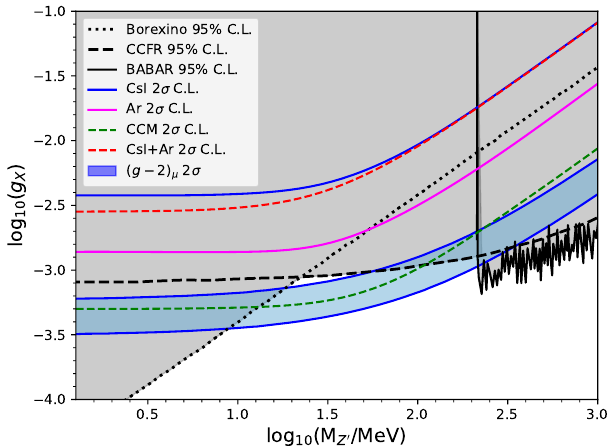
Figure 2. The parameter space of interest in U(1) L models where ( g − 2) µ can be explained µ − L τ by the Z 0 contribution alone is highlighted in blue. Strongest present constraints [44–46, 55] are shown alongside the highlighted region. The COHERENT CsI, Ar and combined limits are from a likelihood analysis [54] of the recently released full data. The Coherent CAPTAIN-Mills (CCM) exclusion is shown assuming 3 years of data taking at the running